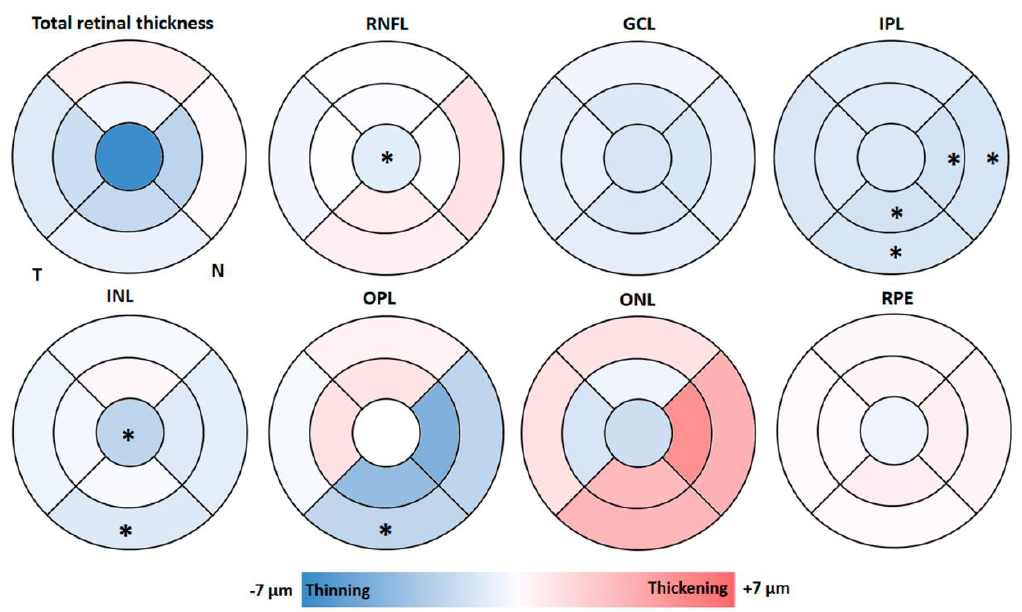
Figure 3. Colorimetric differences in the retinal thickness in each layer between the groups. FH+ ApoE ɛ 4 carriers vs. FH − ApoE ɛ 4 no-carriers in the macular OCT rings. In red, thickening; in blue, thinning. (RNFL: retinal nerve fiber layer; GCL: ganglion cell layer; IPL: inner plexiform layer; INL: inner nuclear layer; OPL: outer plexiform layer; ONL: outer nuclear layer; RPE: retinal pigment epithelium). * p < 0.05. Mann–Whitney U test.